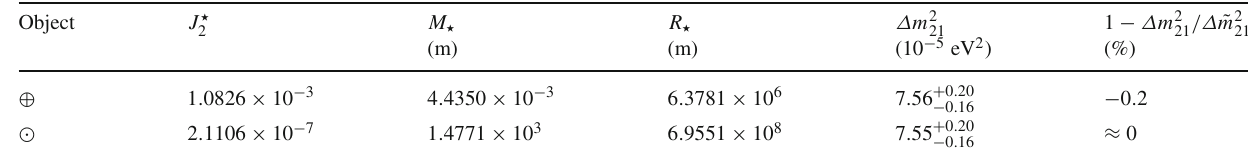
Table 1 The estimate of Δ m 2 without the effects of the quadrupole 21 moment for the Earth ( ⊕ ) and the Sun ( (cid:14) ). Columns list, respectively: the dimensionless quadrupole moment, the mass and the radius of the